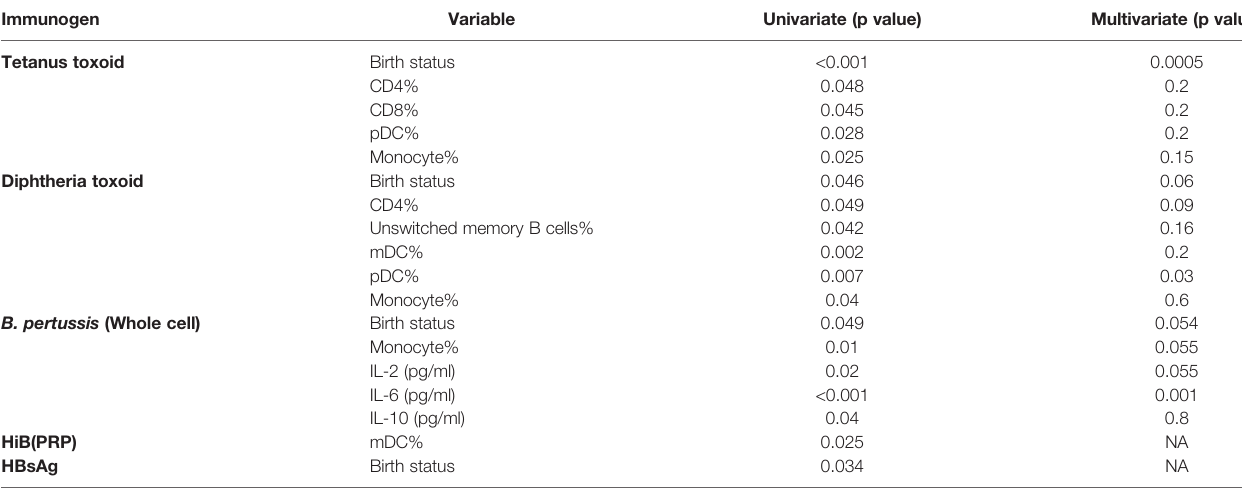
TABLE 6 | Multivariate analysis to identify independent variables in fl uencing antibody response to the pentavalent vaccine components*.